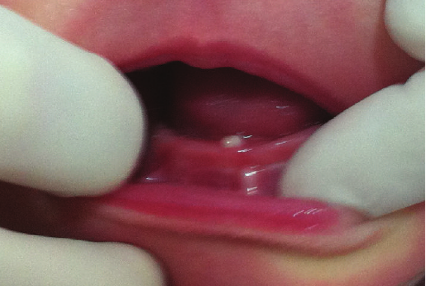
Figure 3: Picture showing complete healing of the lesion 15 days postoperatively.